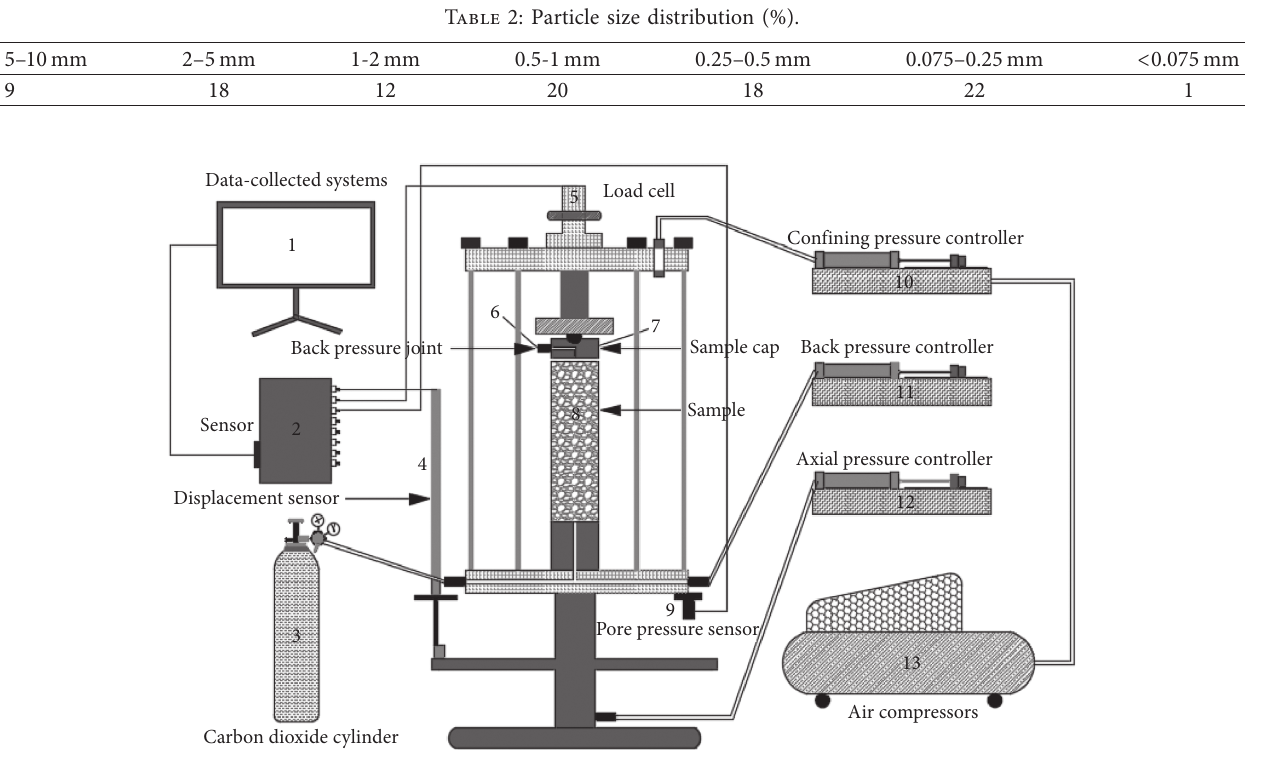
Figure 2: The standard stress path triaxial test system. Table 3: Experimental design of gravelly